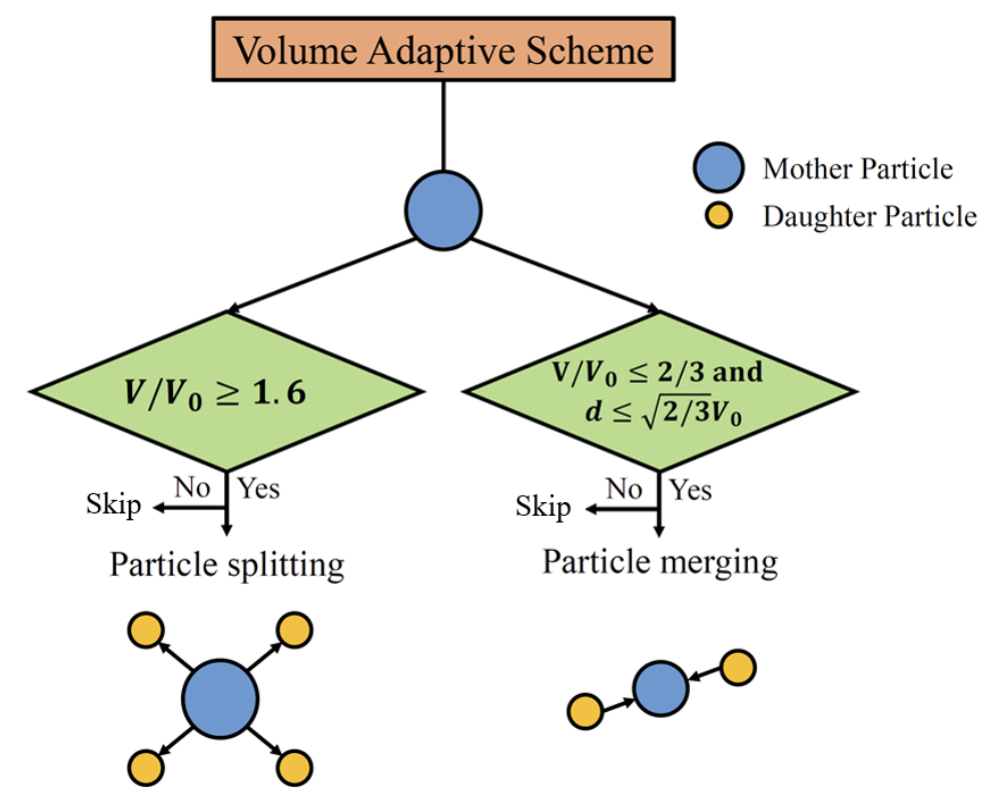
Figure 14. Schematic diagram of the particle splitting and merging process in the VAS technique